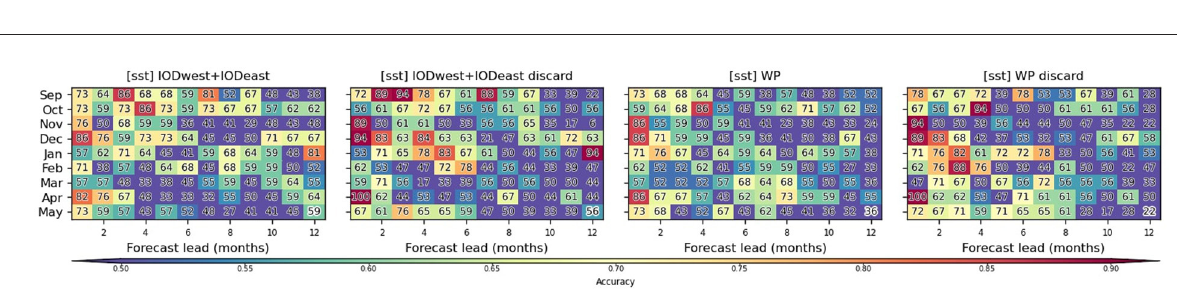
FIGURE7 Predictions for Mopani: Similar to Figure 6 but for the district of Mopani instead of Vhembe. Results from additional experiments, labeled as discard, in which ambiguous categories and 2017 malaria data are discarded, are also